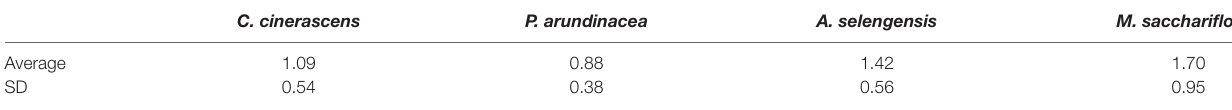
TABLE 4 | Statistical characteristics of AGB of four vegetation communities of field sampling in 2016 December.